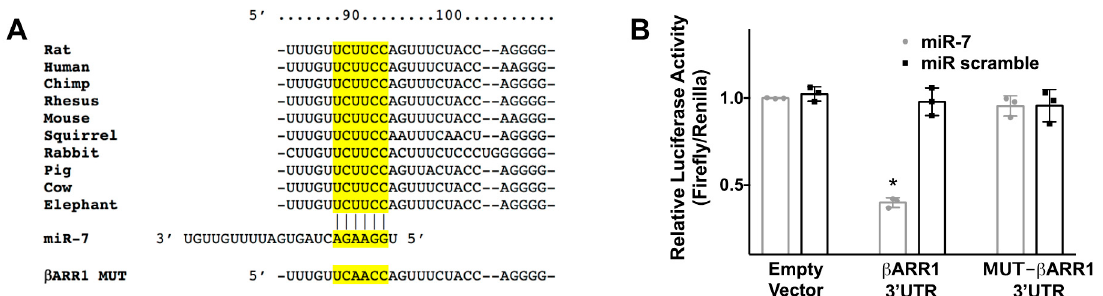
Figure 1. Identification of miR-7 as modulator of β ARR1. ( A ) Complementary nucleotides between the target region of β ARR1 3 ′ -UTR (in yellow) and hsa-miR-7-5p (miR-7) are conserved across different species. Luciferase activity was measured 48 h after transfection, using the vector without β ARR1 3 ′ -UTR (empty vector), the vector containing the wild-type β ARR1 3 ′ -UTR, and the vector containing a mutated β ARR1 3 ′ -UTR ( β ARR1 MUT); ( B ) A non-targeting miR (scramble) has been employed as further control. Means ± S.E.M. are shown alongside actual values; * p < 0.05.